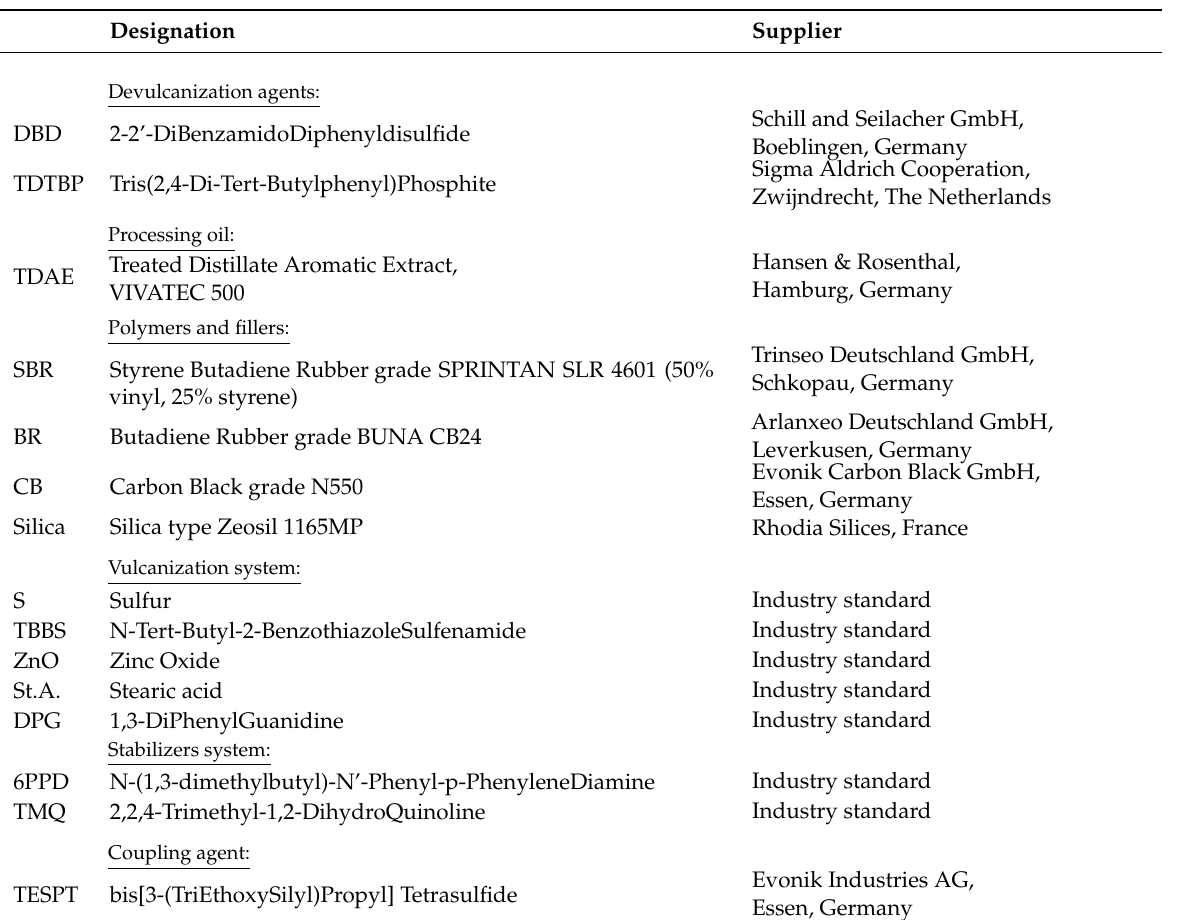
Table 10. Materials